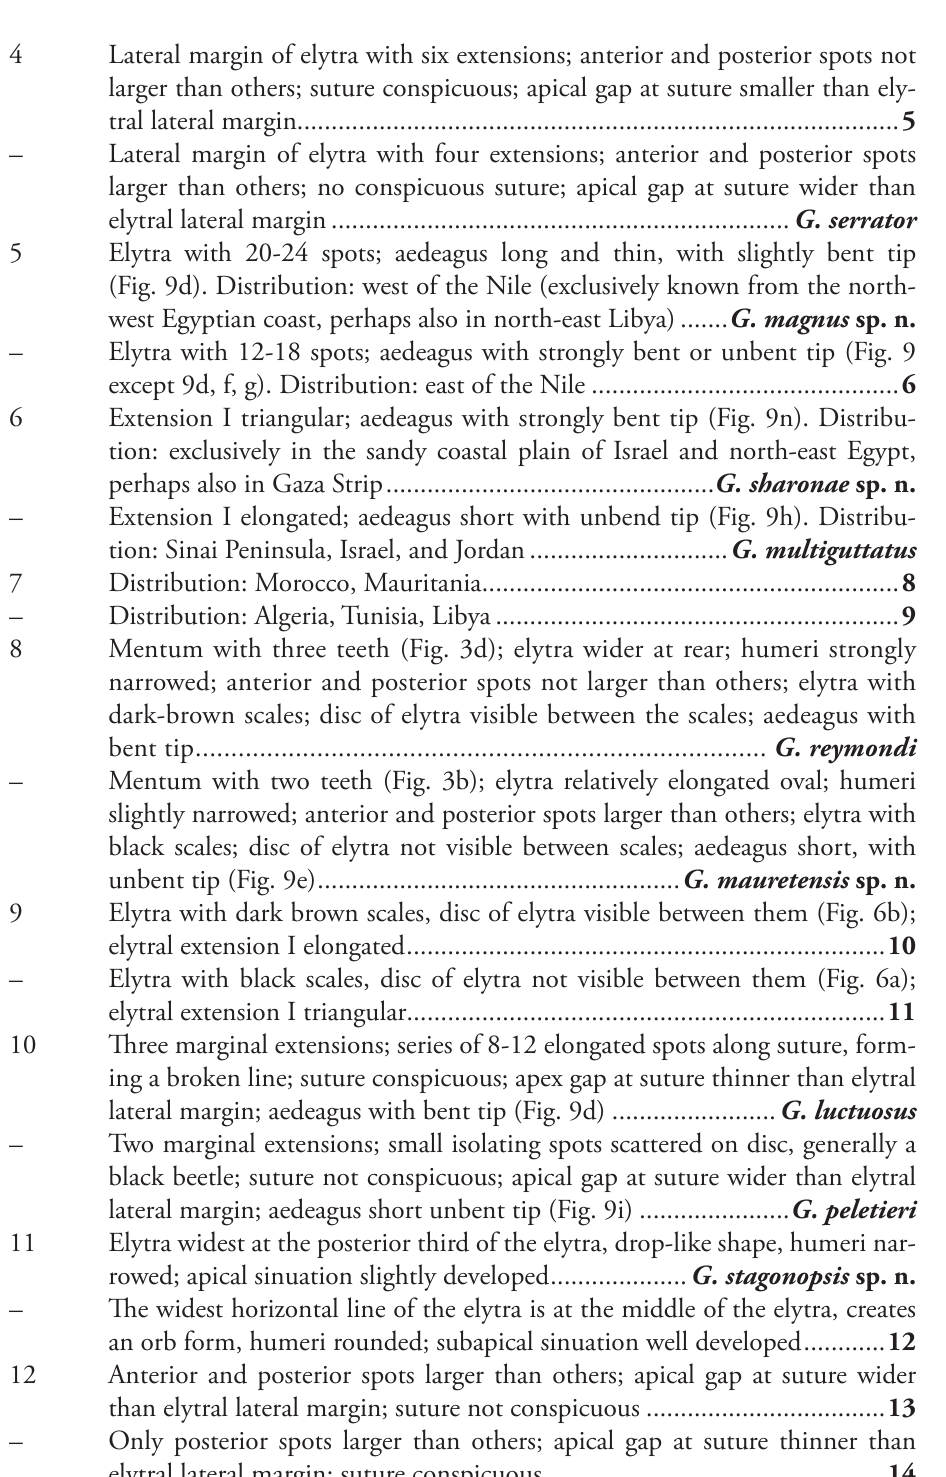
Lateral margin of elytra with six extensions; anterior and posterior spots not larger than others; suture conspicuous; apical gap at suture smaller than ely- tral lateral margin........................................................................................ 5 – Lateral margin of elytra with four extensions; anterior and posterior spots larger than others; no conspicuous suture; apical gap at suture wider than elytral lateral margin ................................................................... G. serrator 5 Elytra with 20-24 spots; aedeagus long and thin, with slightly bent tip (Fig. 9d). Distribution: west of the Nile (exclusively known from the north- west Egyptian coast, perhaps also in north-east Libya) ....... G. magnus sp. n. – Elytra with 12-18 spots; aedeagus with strongly bent or unbent tip (Fig. 9 except 9d, f, g). Distribution: east of the Nile ............................................. 6 6 Extension I triangular; aedeagus with strongly bent tip (Fig. 9n). Distribu- tion: exclusively in the sandy coastal plain of Israel and north-east Egypt, perhaps also in Gaza Strip ................................................ G. sharonae sp. n. – Extension I elongated; aedeagus short with unbend tip (Fig. 9h). Distribu- tion: Sinai Peninsula, Israel, and Jordan ............................. G. multiguttatus 7 – 8 Mentum with three teeth (Fig. 3d); elytra wider at rear; humeri strongly narrowed; anterior and posterior spots not larger than others; elytra with dark-brown scales; disc of elytra visible between the scales; aedeagus with bent tip ................................................................................ G. reymondi – Mentum with two teeth (Fig. 3b); elytra relatively elongated oval; humeri slightly narrowed; anterior and posterior spots larger than others; elytra with black scales; disc of elytra not visible between scales; aedeagus short, with unbent tip (Fig. 9e) ..................................................... G. mauretensis sp. n. 9 Elytra with dark brown scales, disc of elytra visible between them (Fig. 6b); elytral extension I elongated ...................................................................... 10 – Elytra with black scales, disc of elytra not visible between them (Fig. 6a); elytral extension I triangular...................................................................... 11 10 Three marginal extensions; series of 8-12 elongated spots along suture, form- ing a broken line; suture conspicuous; apex gap at suture thinner than elytral lateral margin; aedeagus with bent tip (Fig. 9d) ........................ G. luctuosus – Two marginal extensions; small isolating spots scattered on disc, generally a black beetle; suture not conspicuous; apical gap at suture wider than elytral lateral margin; aedeagus short unbent tip (Fig. 9i) ...................... G. peletieri 11 Elytra widest at the posterior third of the elytra, drop-like shape, humeri nar- rowed; apical sinuation slightly developed .................... G. stagonopsis sp. n. – The widest horizontal line of the elytra is at the middle of the elytra, creates an orb form, humeri rounded; subapical sinuation well developed ............ 12 12 Anterior and posterior spots larger than others; apical gap at suture wider than elytral lateral margin; suture not conspicuous ................................... 13 – Only posterior spots larger than others; apical gap at suture thinner than elytral lateral margin; suture conspicuous ..................................................